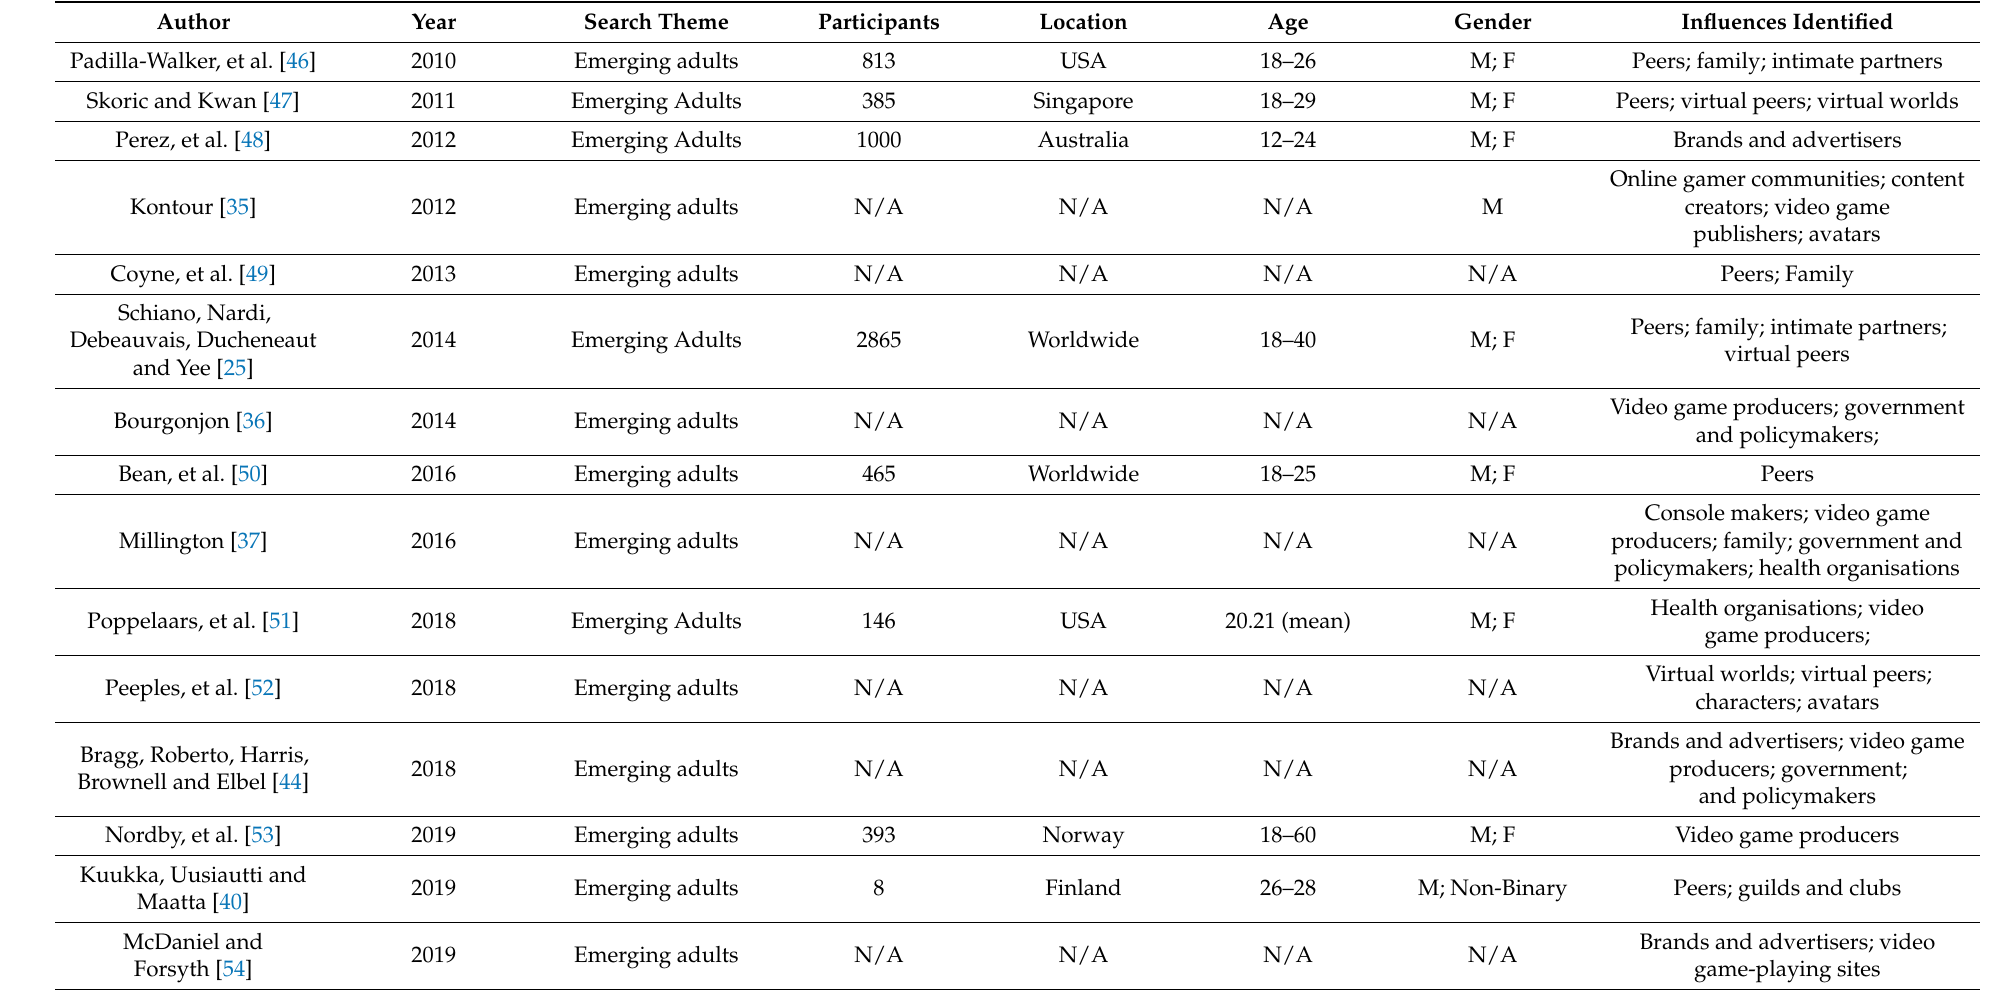
Table 1. Characteristics of scoping review studies from the two independent literature